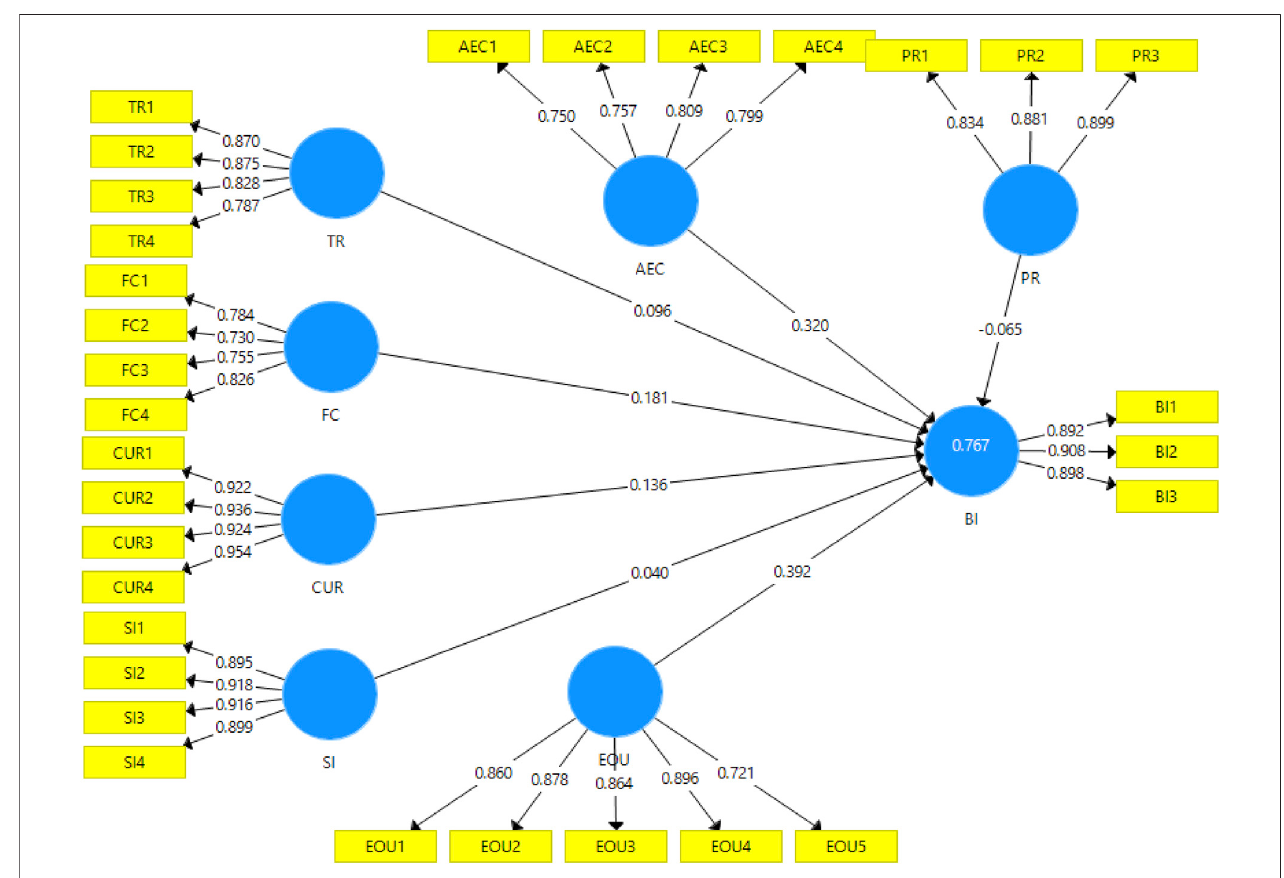
FIGURE 2 | Measurement model.